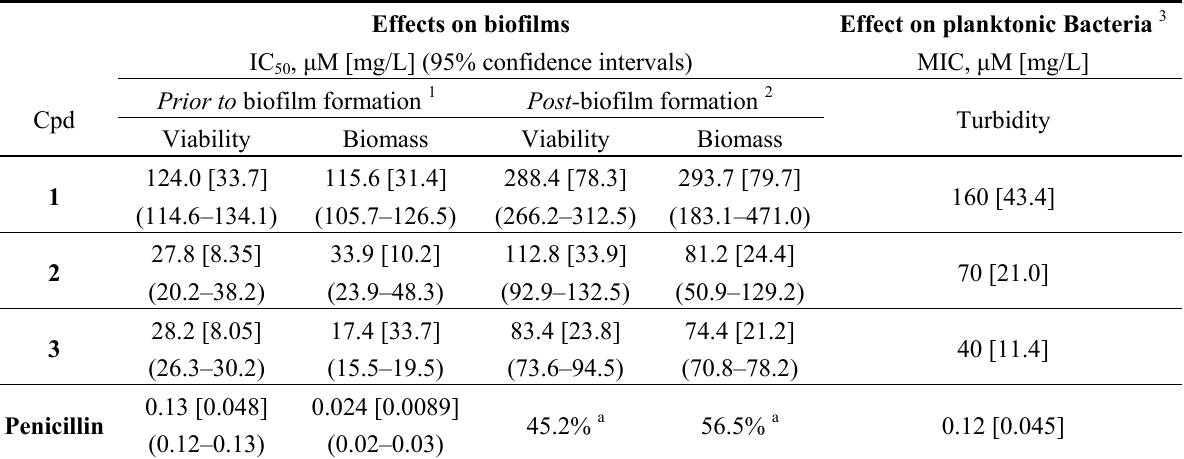
Table 2. Potencies (IC values, expressed in μ M and mg/L) for compounds 1 – 3 measured 50 for anti-biofilm as well as antibacterial effects on planktonic S. aureus . Potency curves were obtained using at least 14 concentration points, with four replicates per concentration in two separate experiments (biological replicates) as described in